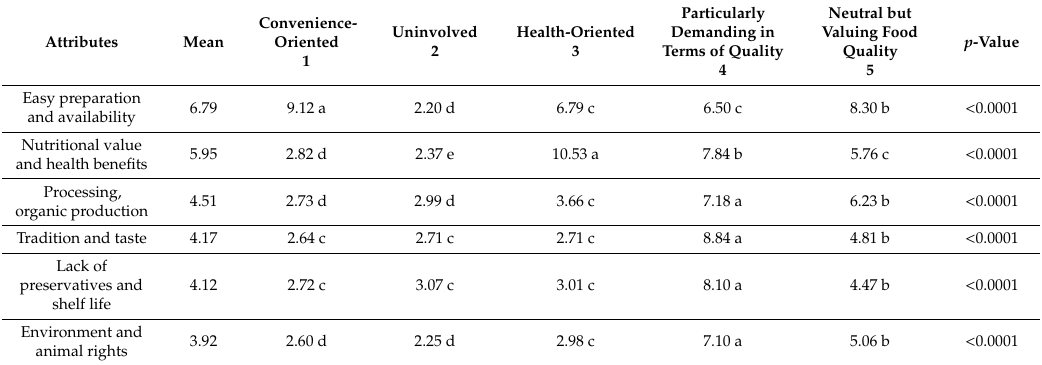
Table 1. Statements used as segmentation variables regarding the characteristics of high-quality products of animal origin.